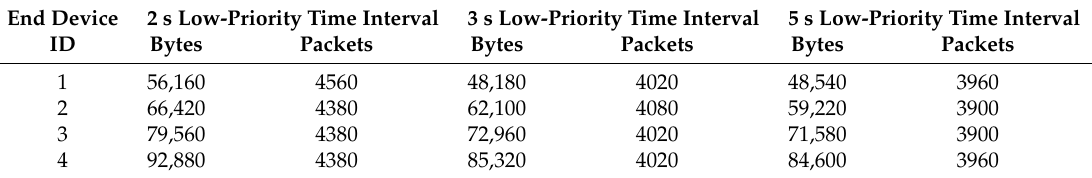
Table 6. Number of processed bytes in the EEMIP mode during a congestion with each 5th packet lost. End